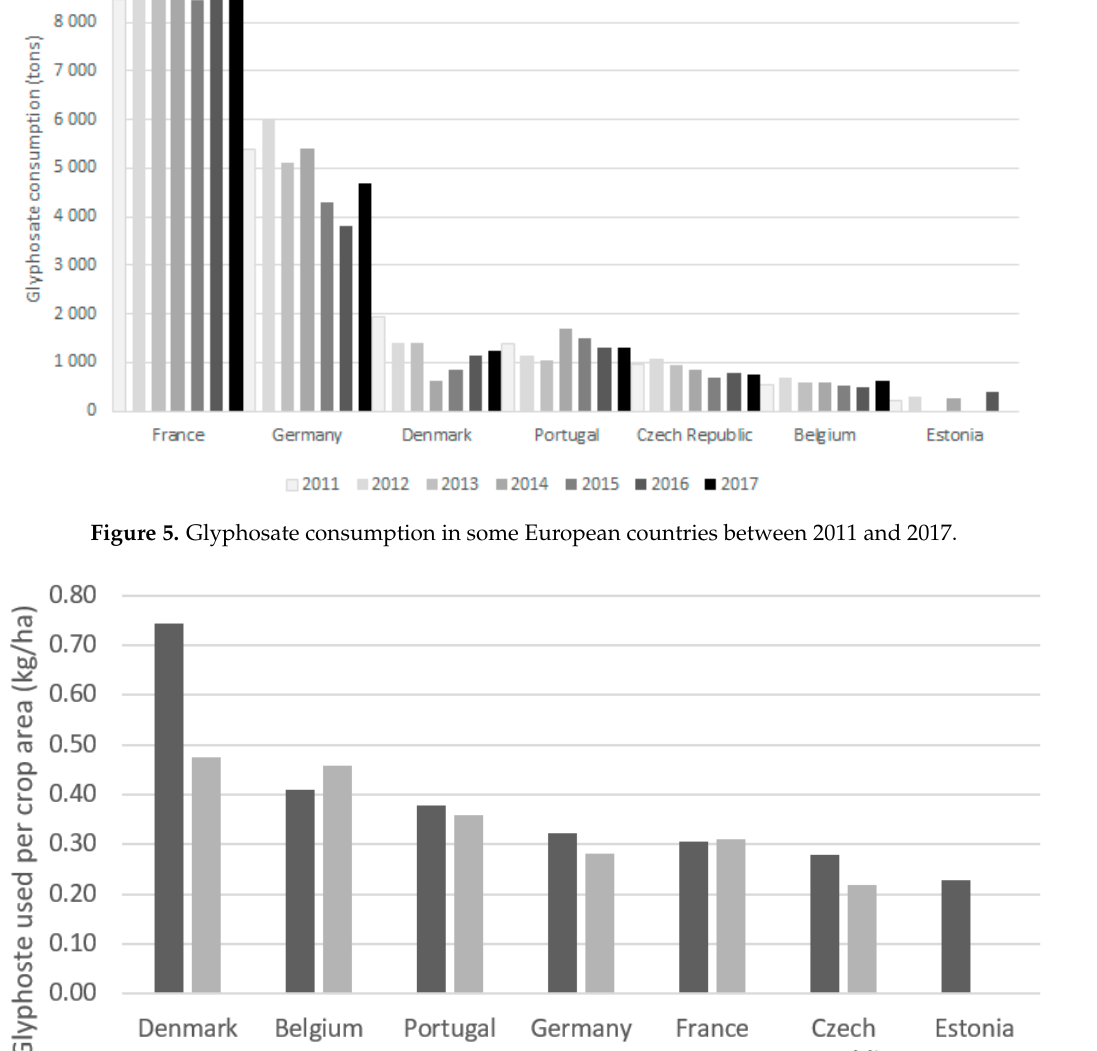
status as the best-selling herbicide in the country throughout the 21st century.